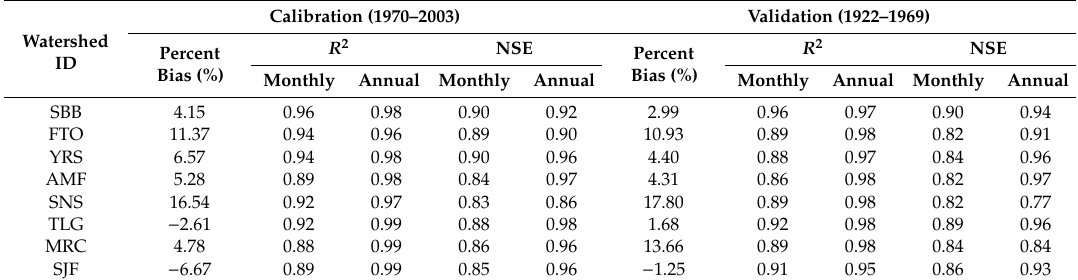
Table A2. Summary of VIC model calibration and validation statistics.